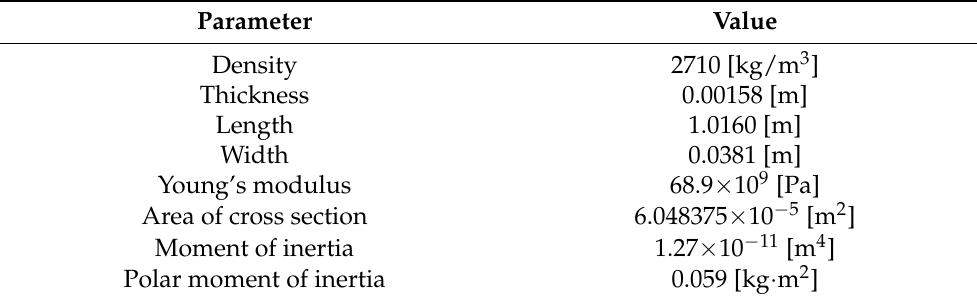
Figure 3. Experimental setup of the cantilever beam submitted to forces with multiple excitation fre- quencies. Table 2. Specifications of the cantilever